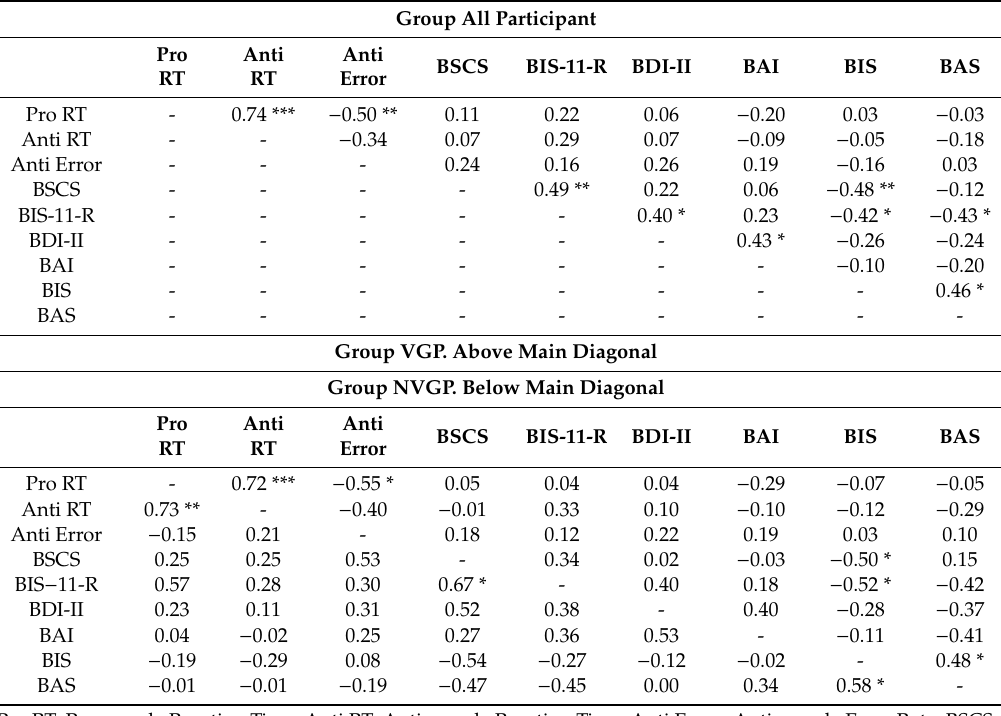
Table 2. Correlation Matrices of all participants, VGP, and